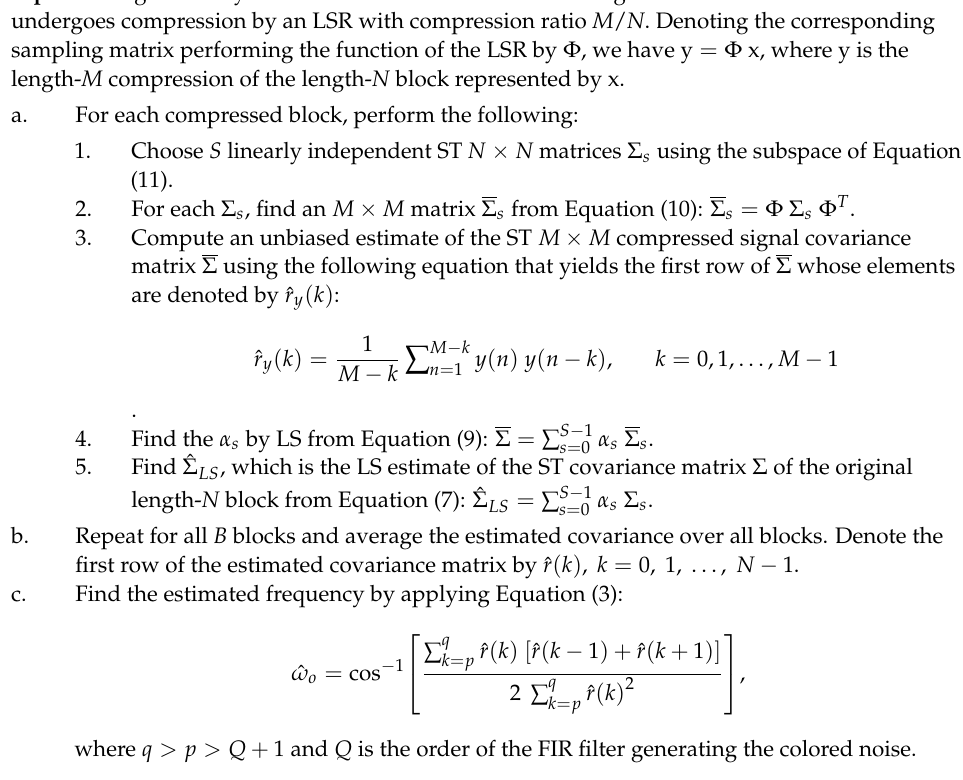
Algorithm 1: CCS-based frequency estimation of a compressed noisy